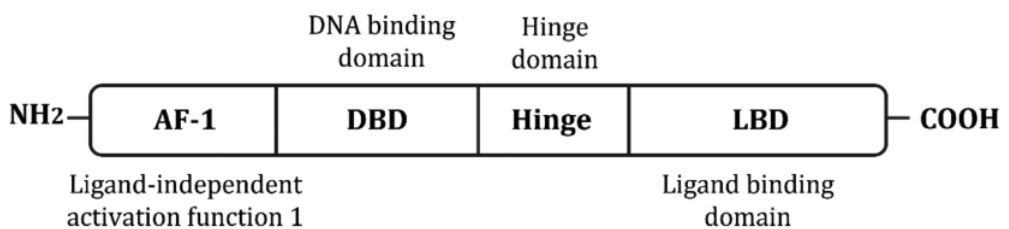
Figure 1 . Representative structure of PPARs. PPAR α , PPAR β / δ and PPAR γ share common structural domains. The AF-1 domain in the amino-terminus facilitates ligand independent activation functions, the DBD domain is necessary for the binding to target PPREs in the target gene promoters. Next to the DBD, the hinge domain allows the binding of regulatory co-factors, while the LBD in the carboxyl-terminus is essential for the physical interactions with the RXR and other co-factors, such as PGC1 α or members of the KLF